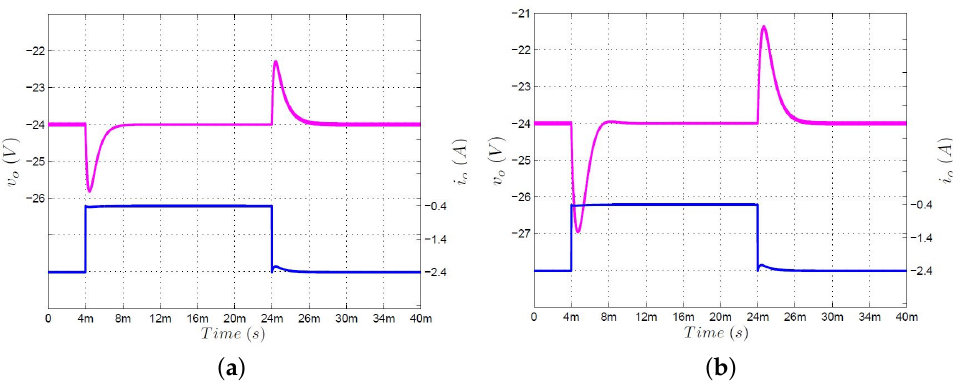
Figure 6. Simulated response of the buck-boost converter under output current transients of 2 A with the LMI-Fuzzy controller ( F LMI − Fuzzy ) and LMI robust controller ( F LMI ). ( a ) Voltage response v o with F LMI − Fuzzy . ( b ) Voltage response v o with F LMI [9].